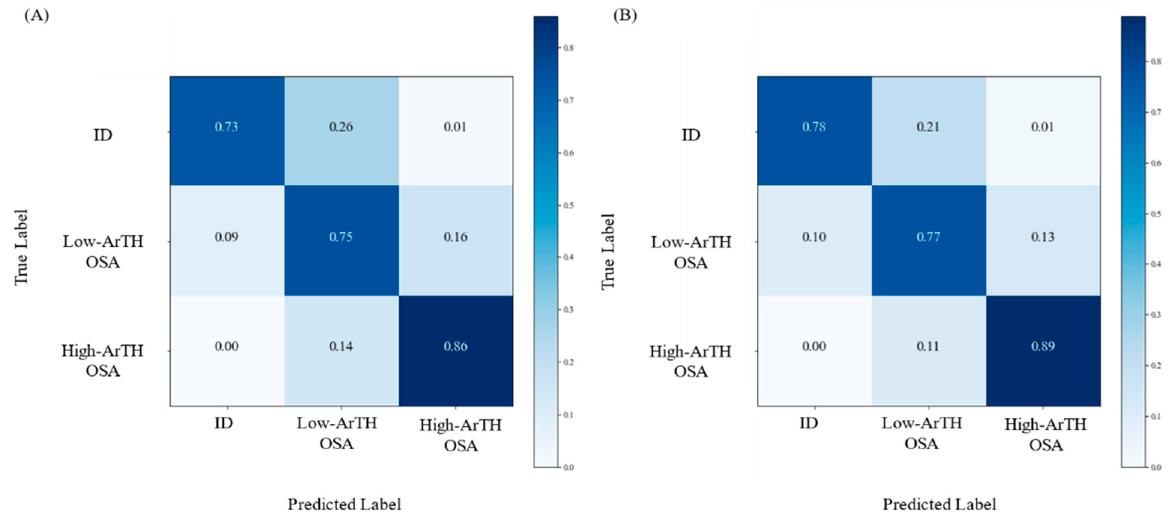
Figure 4. Classification results of the testing set using the selected models (random forest, RF). Con- fusion matrices indicating the accuracy of the multiclass classification using the selected model